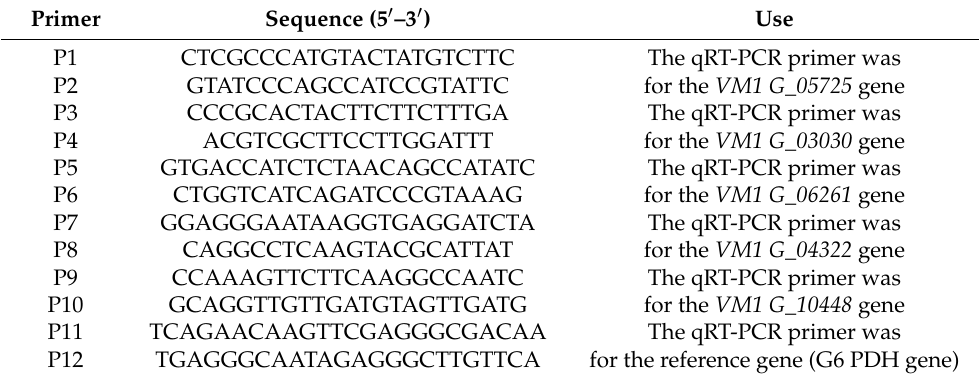
Table 3. qRT-PCR primers used in this